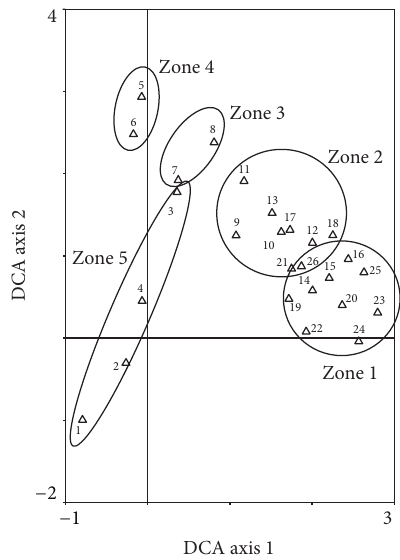
Figure 4: DCA results for 26 representative plant community samples from the Beihong Section.